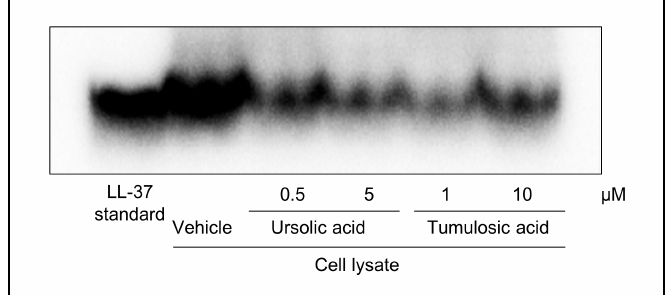
Figure 3. Decrease in LL-37 production in human keratinocytes treated with triterpenoids. Normal human epidermal keratinocytes (NHEKs) were treated with ursolic acid (0.5 μ M and 5 μ M) or tumulosic acid (1 μ M and 10 μ M) or vehicle for 23 h in the presence of 10 μ M cycloheximide. LL-37 peptide in the lysate of cultured cells was detected using immunoprecipitation and Western blotting. Representative results are shown. Recombinant human LL-37 (0.2 ng) was loaded in the leftmost lane as a standard.